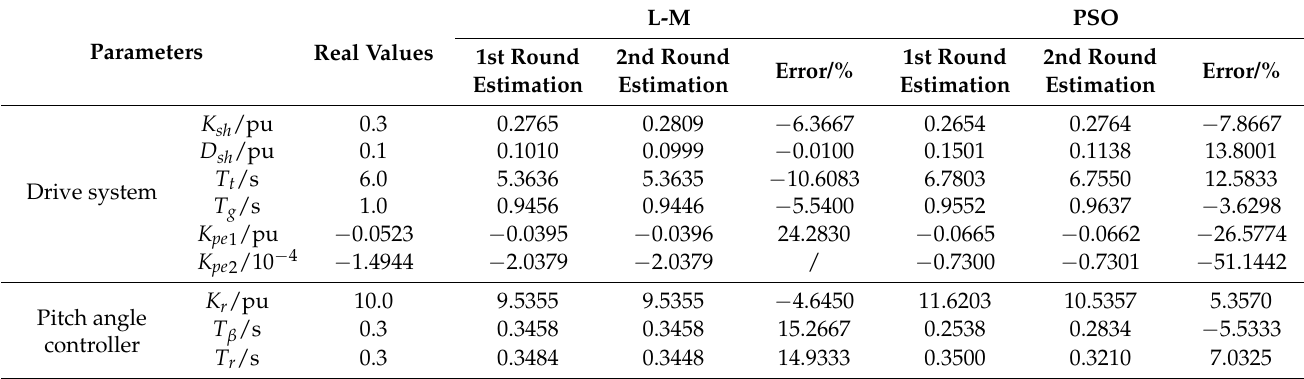
Table 3. Estimated values in two estimation